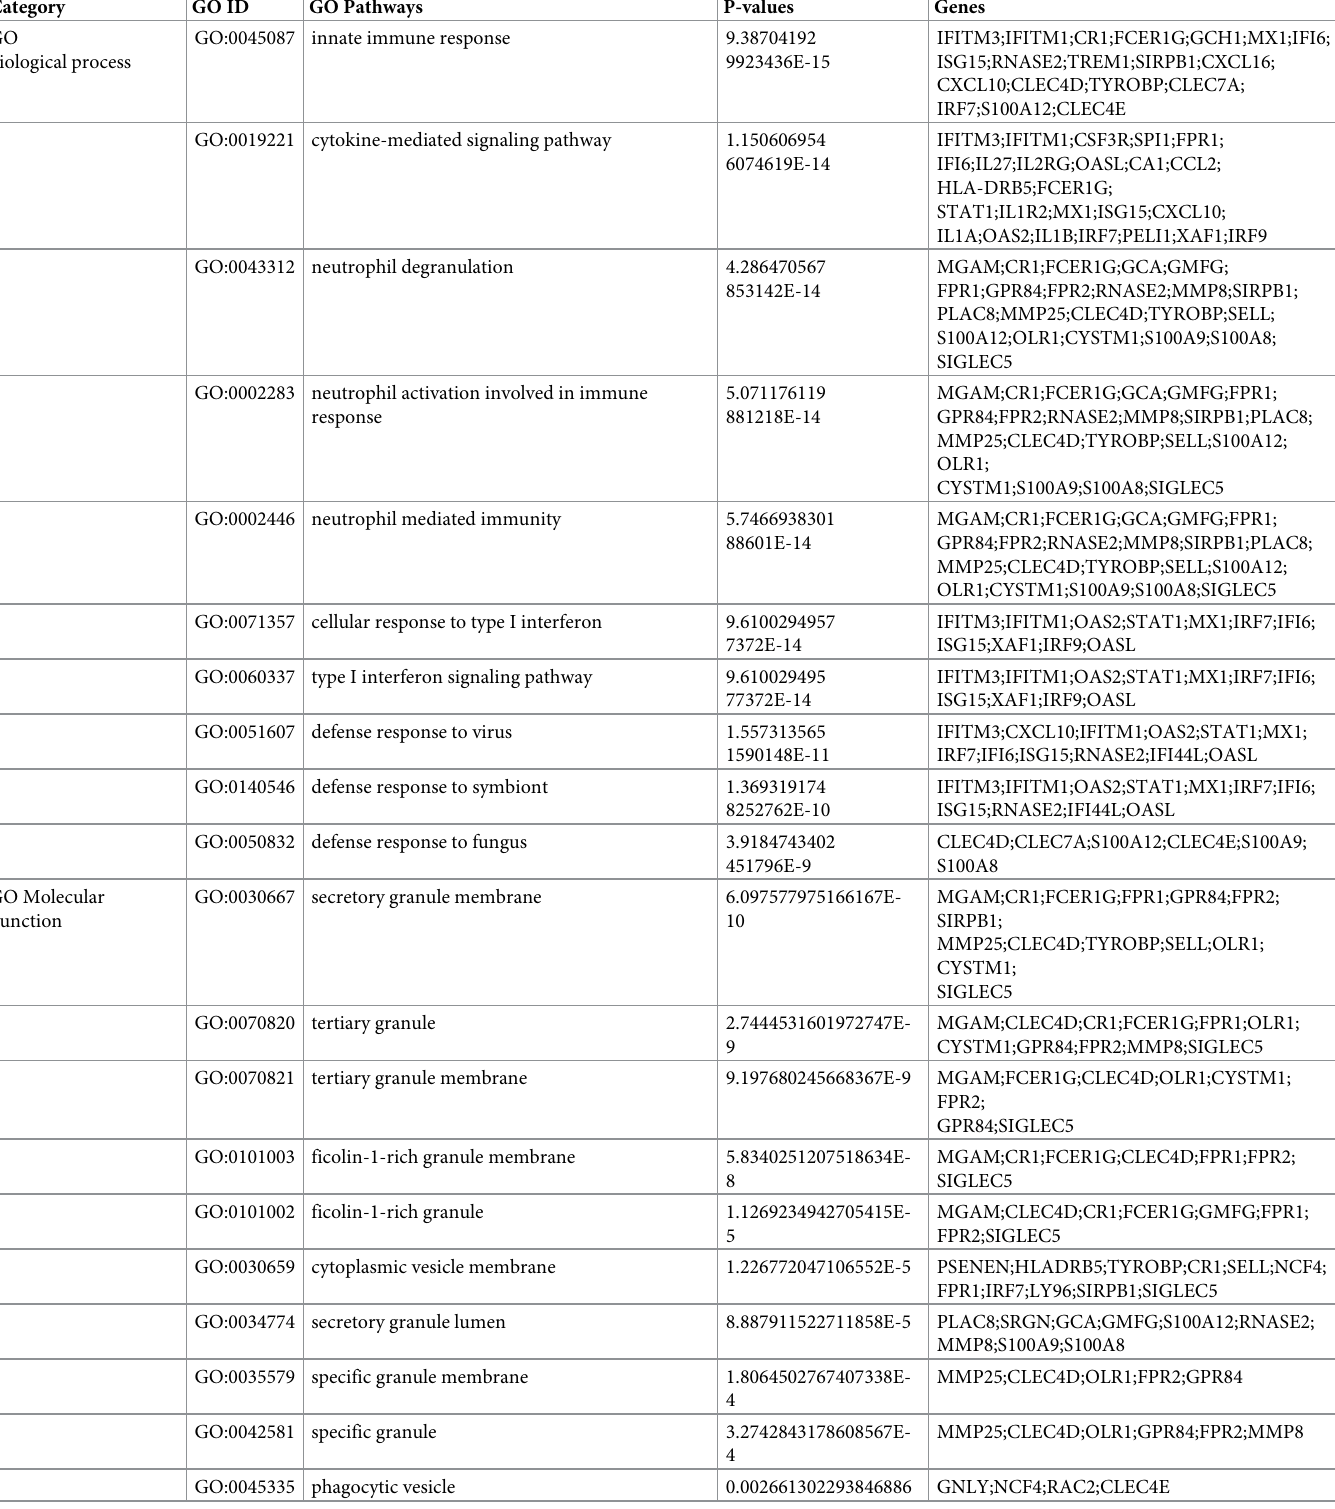
Table 1. Go enrichment analysis of upregulated DEGs between COVID-19 and IPF.